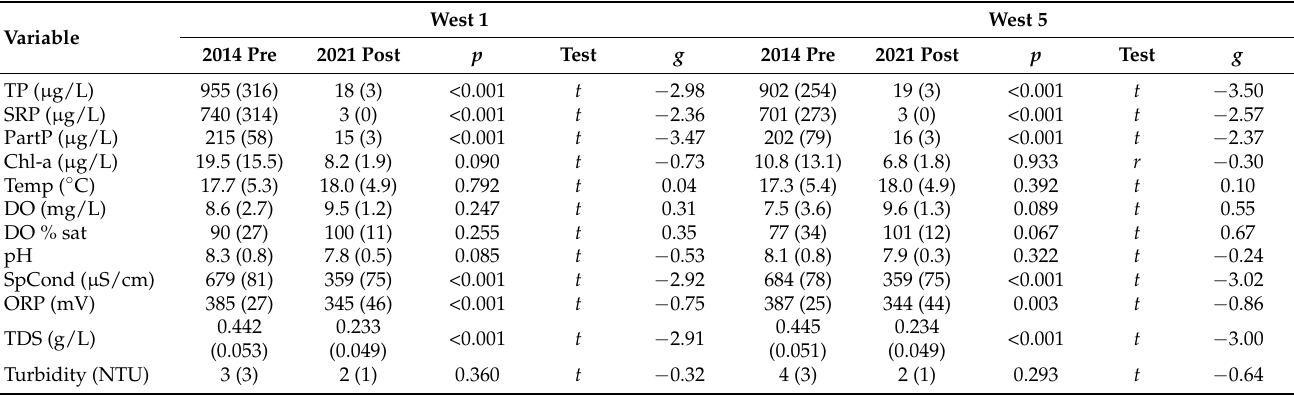
Table 1. West pond sites (1 and 5) pre- vs. post-restoration mean ( ± SD) general water quality statistical analysis results using paired t -tests ( t ) or Wilcoxon signed rank test ( r ), and Hedge’s g -value. For each comparison, n = 7 months (May–October 2020, April 2021). Positive g -values correspond to an increase in the water quality parameter when comparing pre-restoration to post- restoration; negative g -values correspond with decreases in the same manner. TP = total